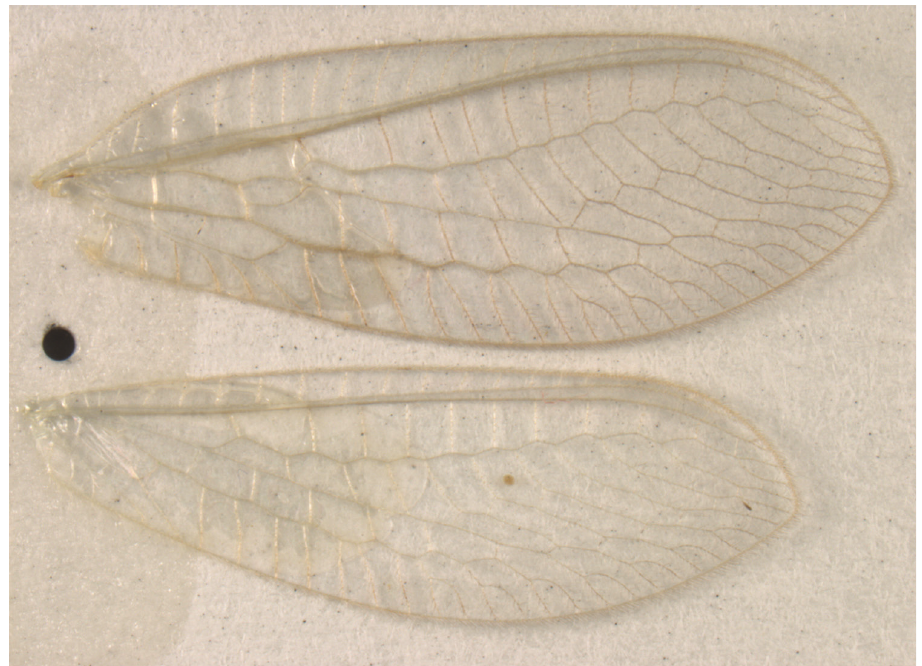
Figure 69. Ungla pallescens Penny: Wings (Costa Rica, Monteverde, paratype, male, CAS). with pair of internal rods extending length of projection; tip of mediuncus rounded, with slight knob; gonosaccus bilobed (mostly unexpanded in the paratype), each lobe with large maleable patch of elongate gonosetae arising from enlarged setal bases, facing medially (not as in Fig. 52 of Penny 1998: 71, but see his description); hypandrium internum V-shaped with rounded apex, arms curved